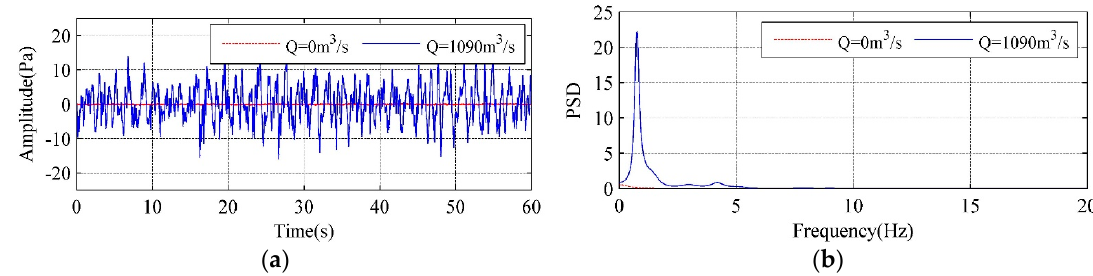
Figure 4. Comparisons of the time history and PSD curves of LFN: ( a ) time history curves; ( b ) power spectral density curves.